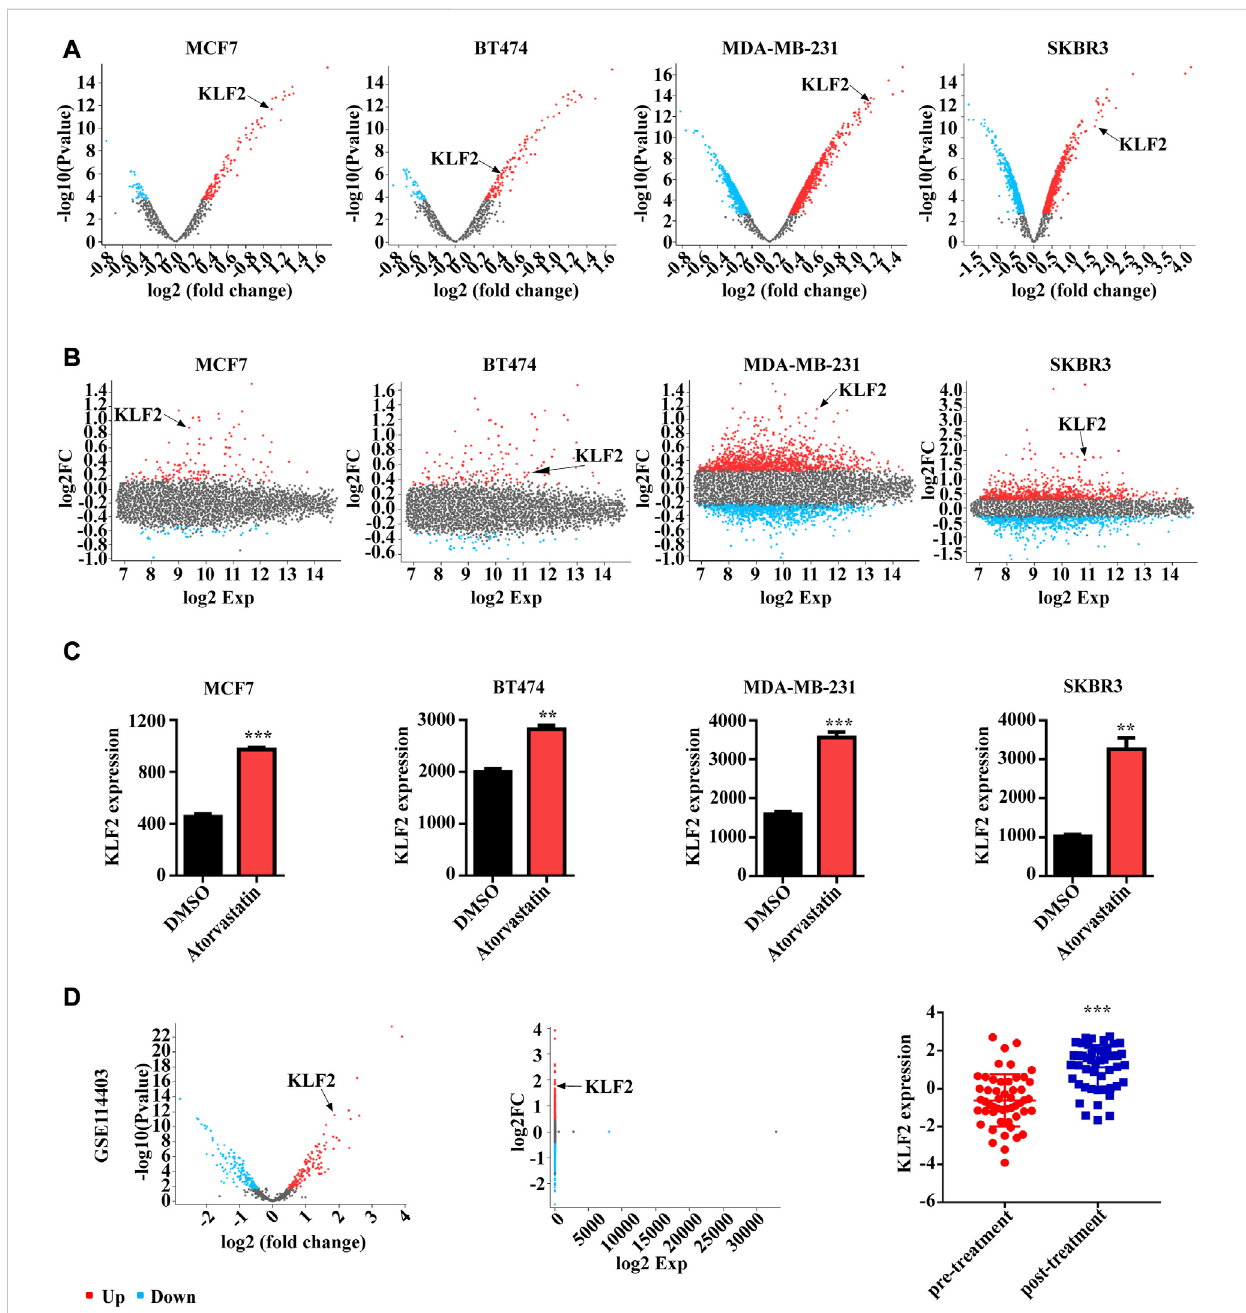
FIGURE 8 The relationship between KLF2 expression levels and clinical treatment in breast cancer. The volcano plot (A) and meandiff plot (B) depict the atorvastatin-induced transcriptional changes in breast cancer cells, MCF7, BT474, MDA-MB-231 and SKBR3. (C) KLF2 expression value after atorvastatin treatment in GSE63427. (D) The volcano plot, meandiff plot and KLF2 expression in GSE114403. p , p < 0.05; pp , p < 0.01; ppp , p < 0.001; ns, no signi fi